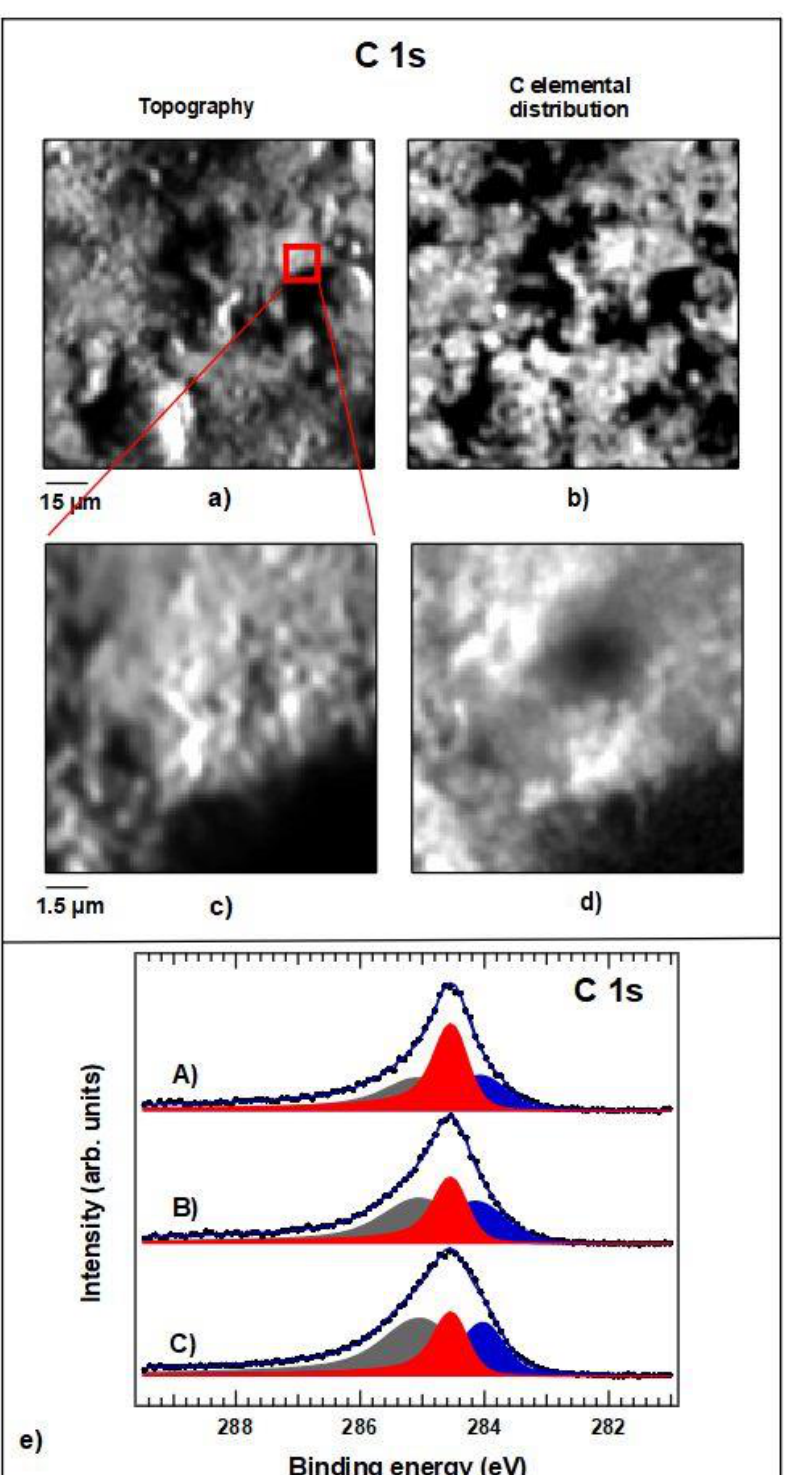
Figure 13. ( a ) and ( b ): raw data SPEM image acquired at the C 1s level and the corresponding C elemental distribution. ( c ) — same maps of the magnified region indicated by the red square in image and ( d ) same maps of a magnified region after processed. ( e ): representative C 1s spectra acquired at different locations. The three color filled lines are the result of the deconvolution procedure, which separates the contribution of the different chemical C moieties. See text for the details.